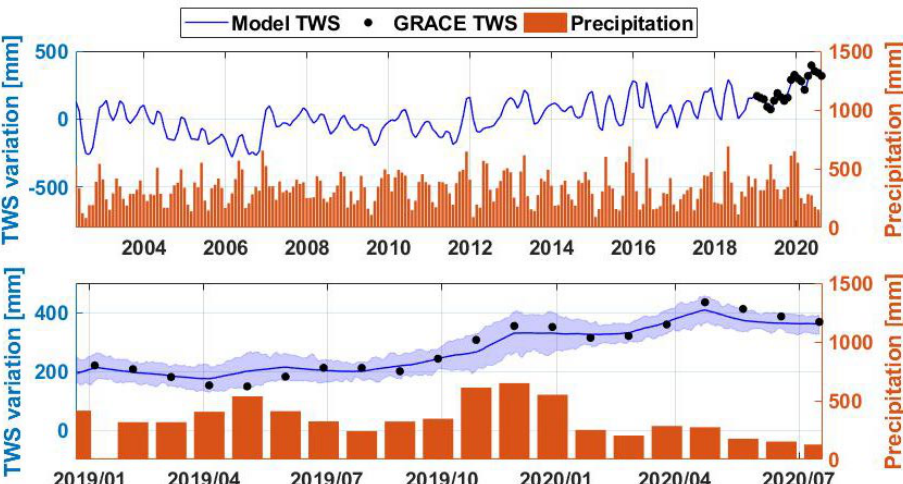
Figure 3. ( Top ) Average TWS change and precipitation time series over the Lake Victoria region during the period 2002–2020; ( Bottom ) Time series are represented for the period 2019–2020 with the assimilation uncertainty in shaded blue. More rains and subsequent lake level increase occur